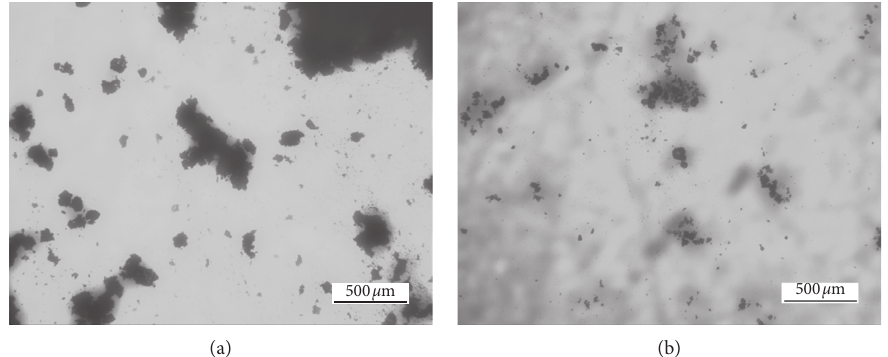
Figure 8: Scheelite particles ( − 10 μ m) in ultrapure water: (a) pH 8; (b) pH 10.